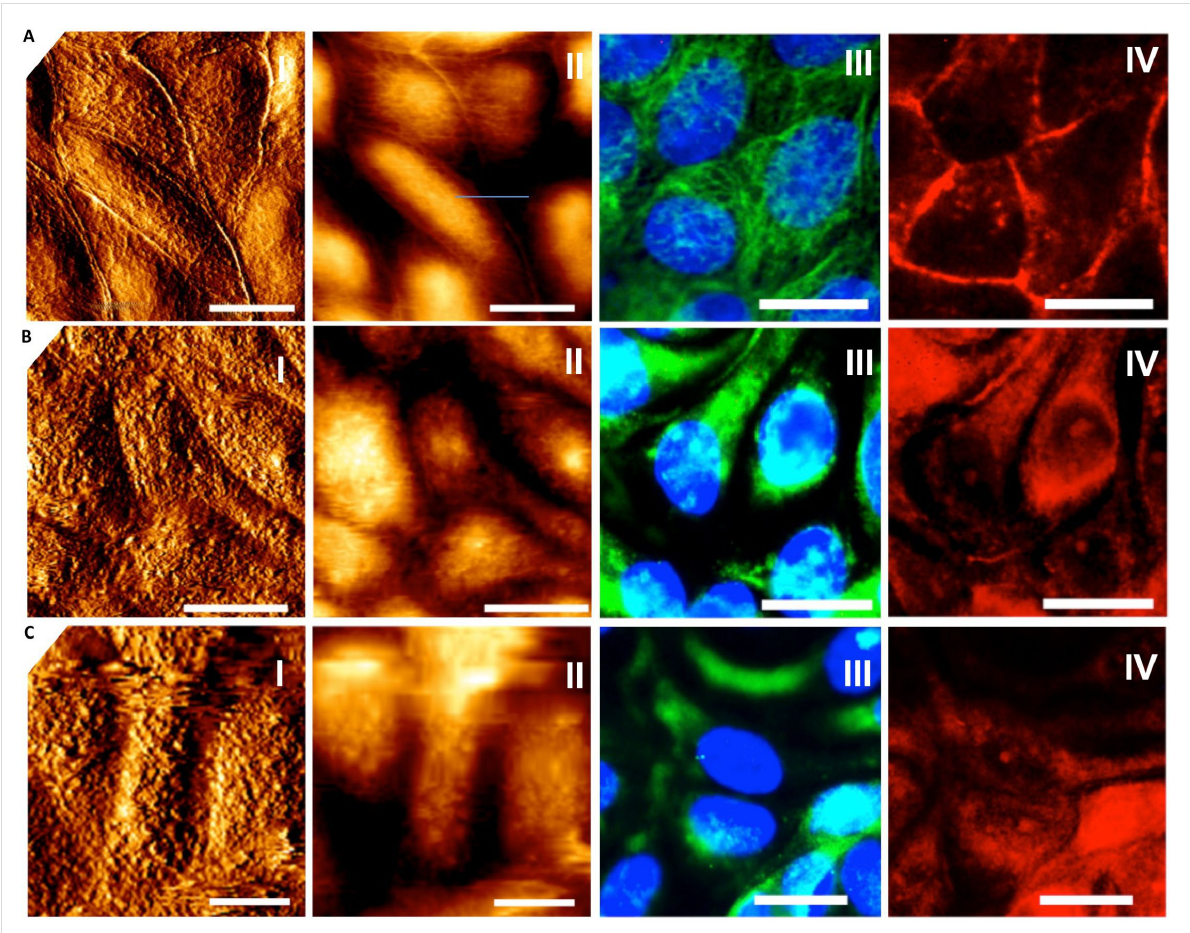
Figure 1: Confluent MDCK II cells treated with different concentrations of CTAB functionalized gold nanorods. A: untreated cells. B: cells incubated for 24 h with 6 μ g/mL CTAB rods. C: cells incubated for 24 h with 24 μ g/mL CTAB rods. I: AFM contact mode height images. II: deflection images. III: fluorescence microscopy images of microtubules (green) and nucleus (blue). IV: fluorescence microscopy images of F-actin filaments (red). Scale bar: 10 μ